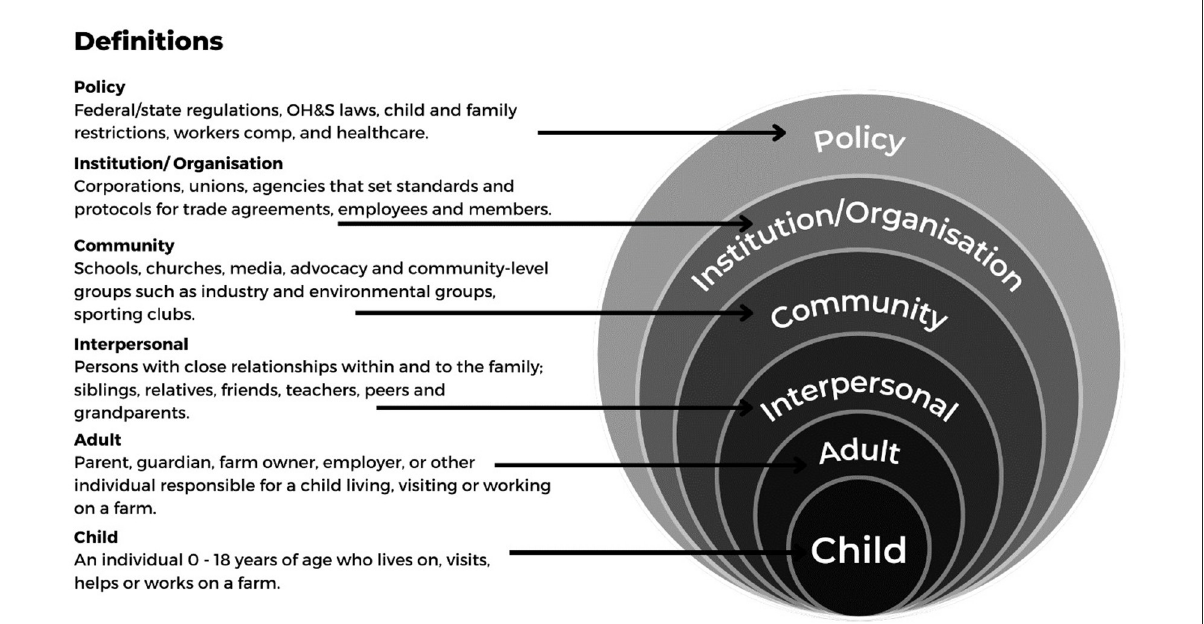
FIGURE1 The socioecological model adjusted for young people and farm safety. Adapted from Lee et al.